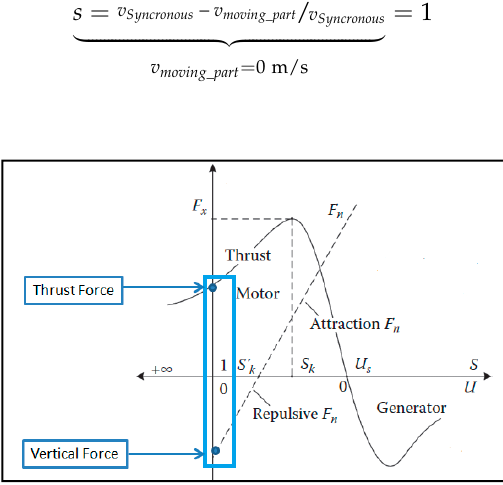
Figure 5. Curve forces versus slip in an LIM [ 18].